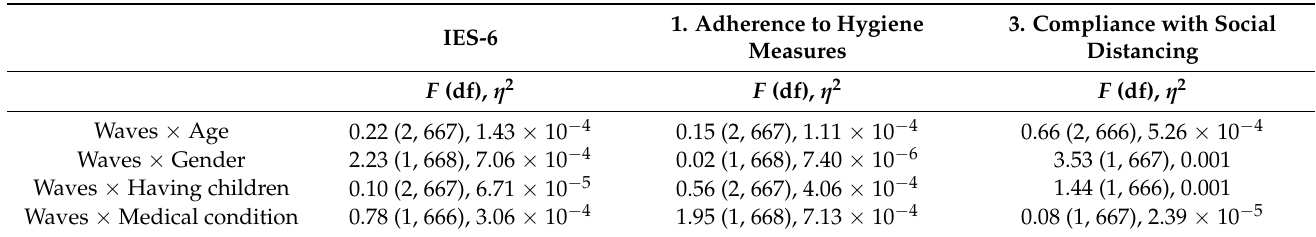
Table 4. Repeated measures ANOVA testing interactions of distress between waves and significant sociodemographics a .